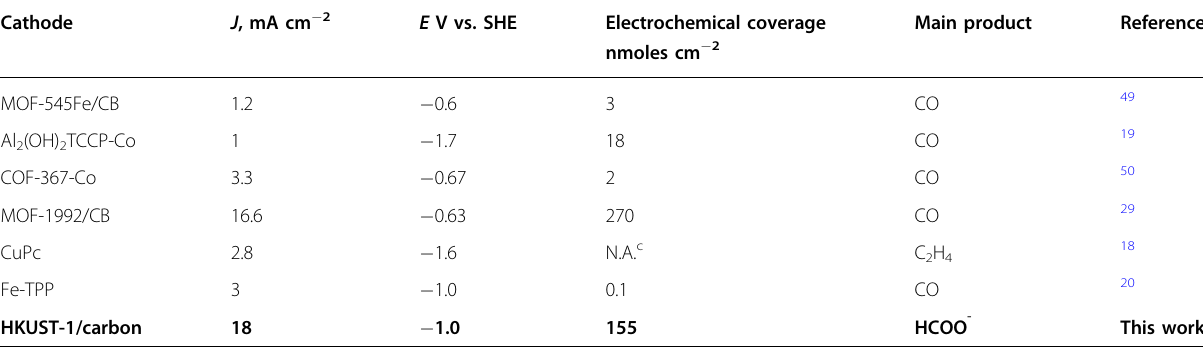
Table 2 Performance of different MOF-based cathodes for CO 2 electroreduction.